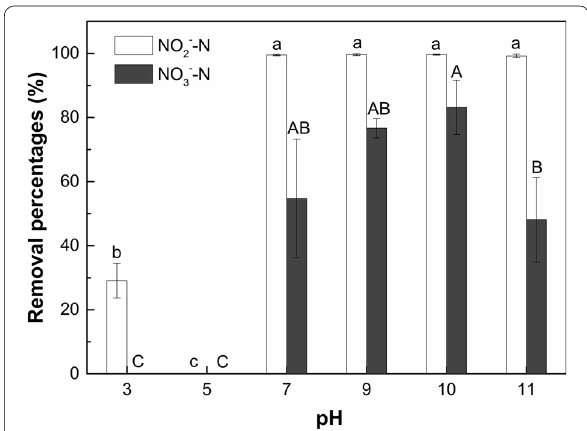
Fig. 5 Effect of initial pH on denitrification capacity of strain F1 in saline condition (10 g/L NaCl). Values represent the mean of three replicates and error bars represent standard deviations. Columns containing different letters indicate significant differences among treatments at p < 0.05 by Tukey’s